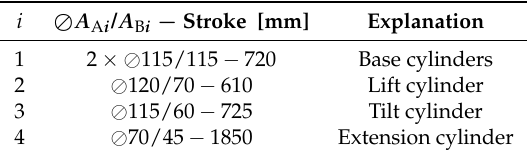
Table 1. Hydraulic cylinder dimensions of the test-bed